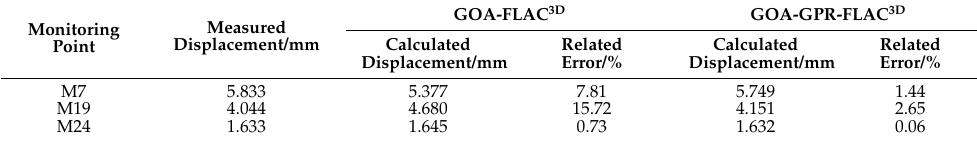
Table 6. Comparison of displacements obtained from calculation and